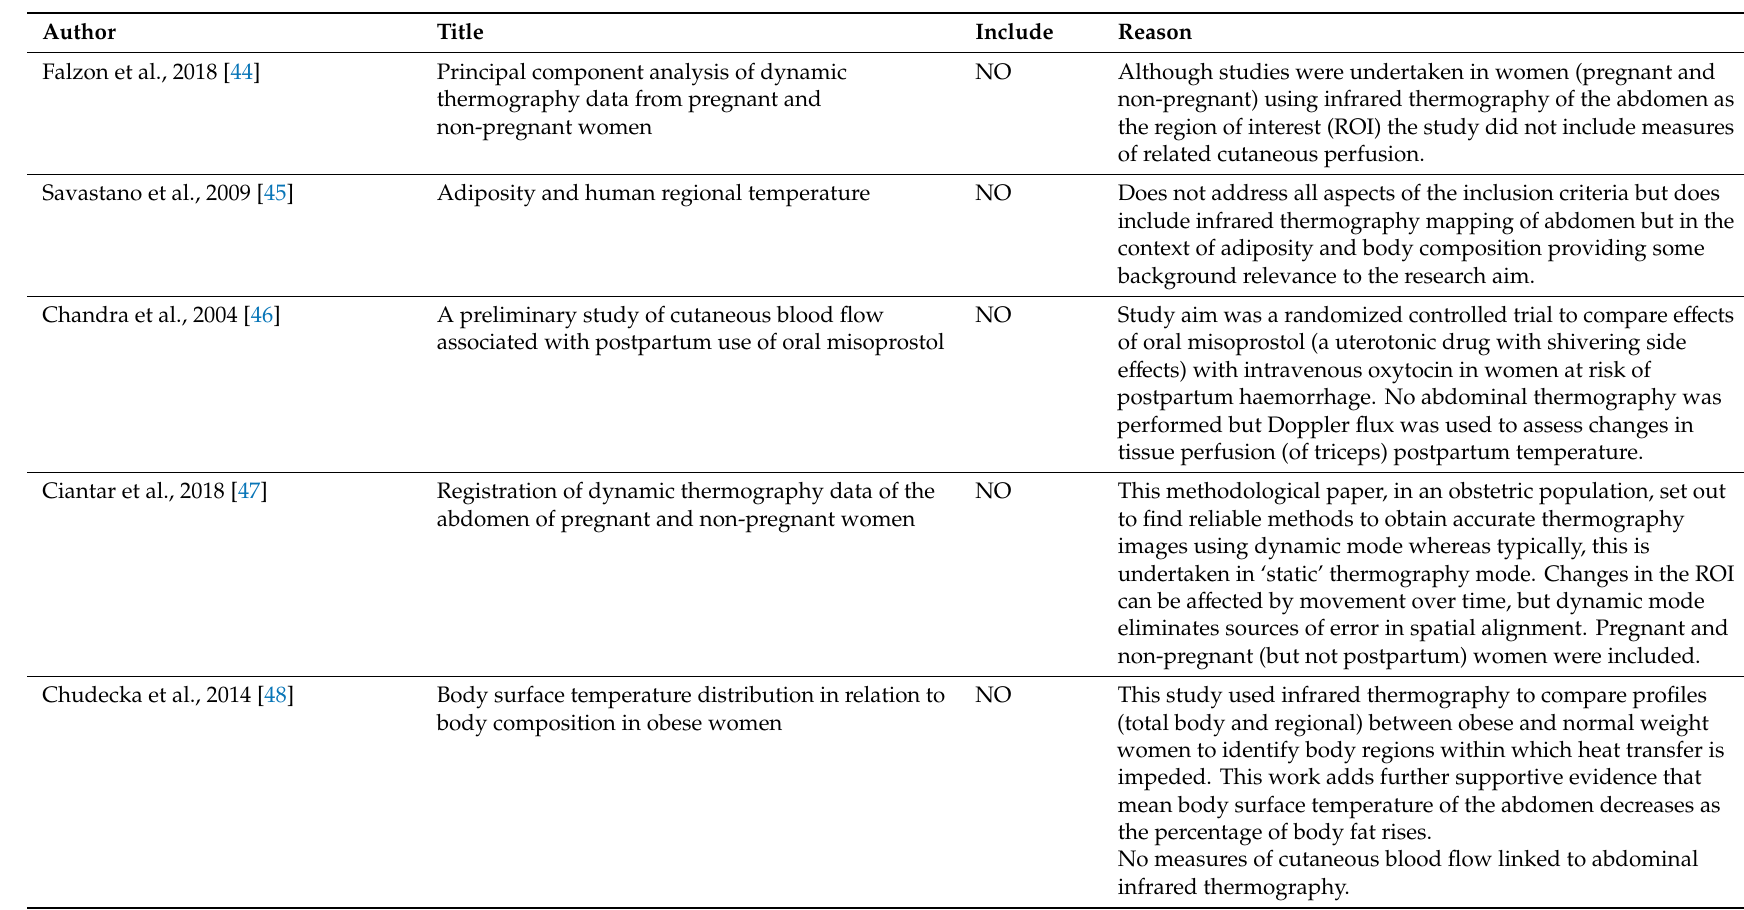
Table 2. Justification for exclusion of retrieved